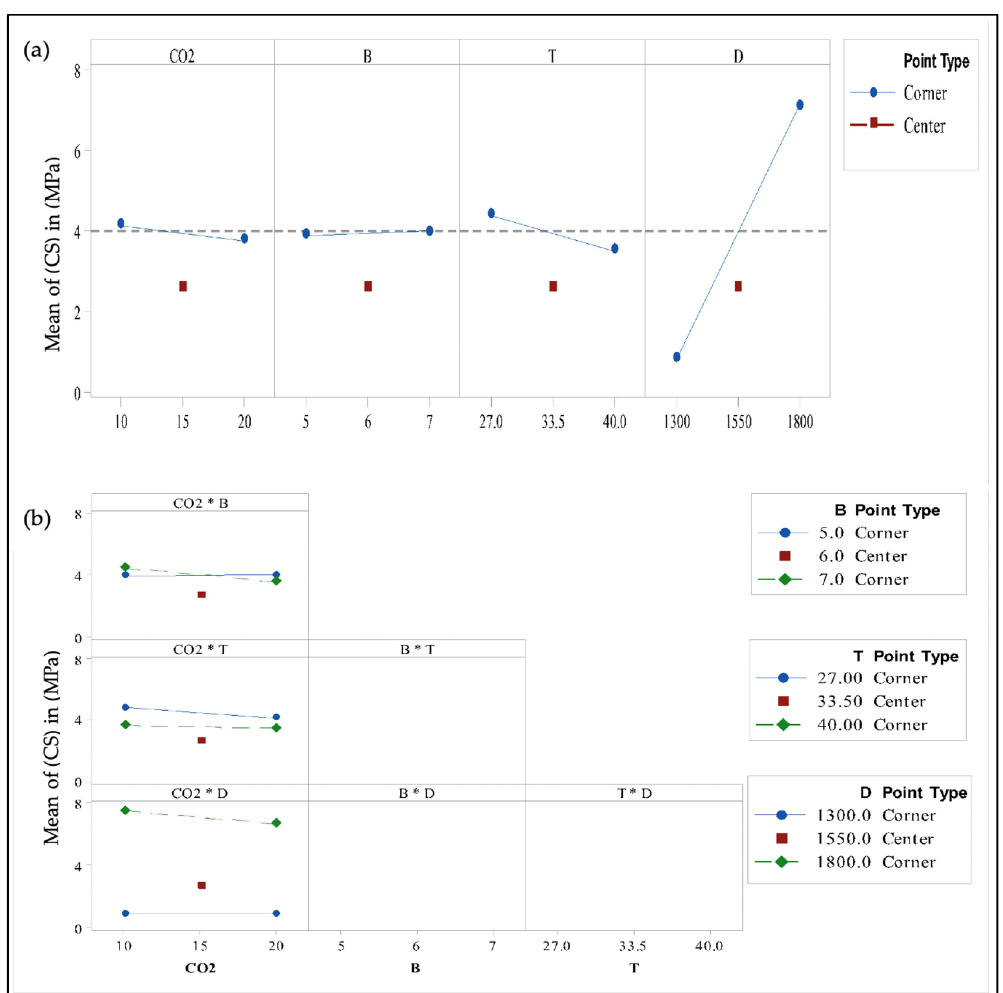
Figure 2. Results of factorial analysis with curvature test: ( a ) Main effect plot of compressive strength, and ( b ) Interaction plot of compressive strength.